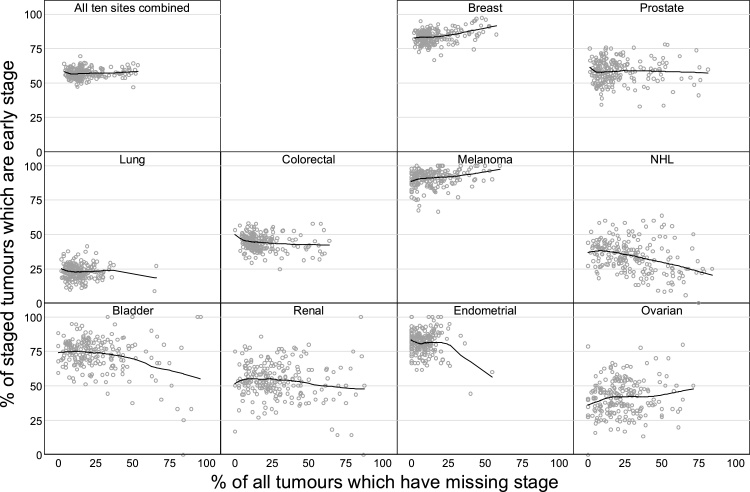
Percentage of staged tumours which were stage 1 or 2 against percentage of all tumours which were staged, by CCG, England 2013, with LOESS line.